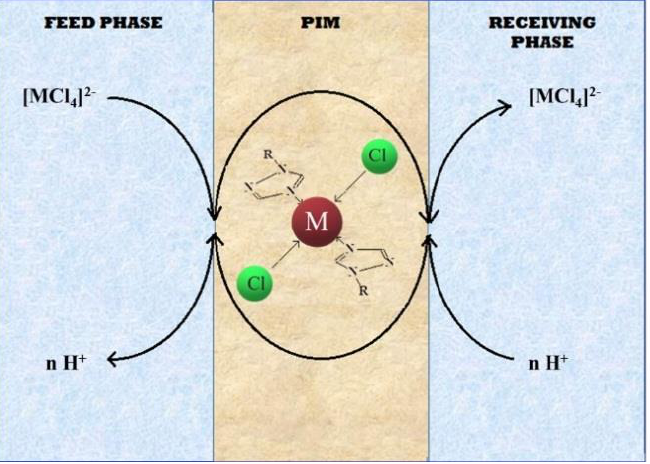
Figure 4. Transport scheme across PIMs with 1-alkyl-triazole ( 1 – 9 ).